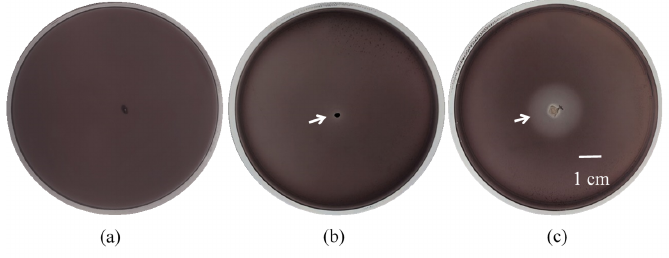
Figure 2. Clear zone formed on NA supplemented with 0.5% ( w / v ) of tannic acid by extracellular tannase produced from tannin-tolerant Bacillus spp. isolates incubated at 37 °C for 48 h. No clear zone formed ( a ), smallest clear zone formed ( b ), and widest clear zone formed ( c ). Arrows indicate clear zone formed.